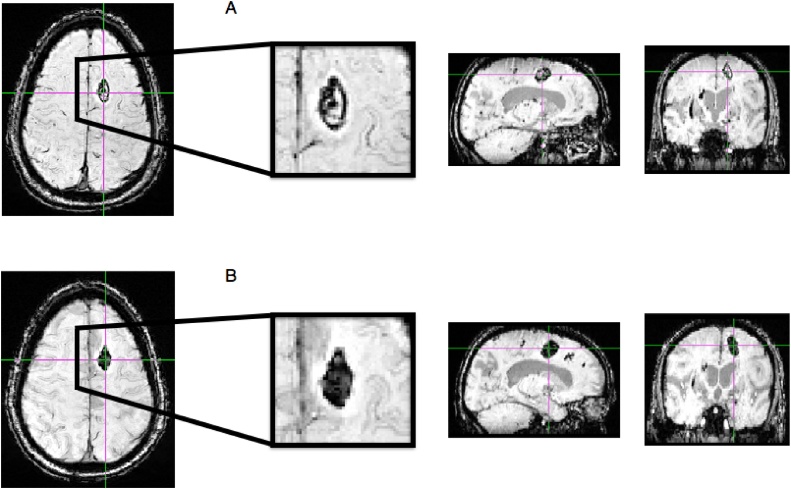
Susceptibility-weighted MR images illustrating change in volume in patient 2.Figure 3 Legend. Representative axial, coronal and sagittal images with magnified axial views of the left superior frontal gyrus region from patient 2 in whom an increase in total traumatic cerebral microbleed (TCMB) volume was seen between scan 1 (A) (1819 mm3) and scan 2 (B) (2845 mm3), 7 days apart. This patient did not experience an improvement in GCS between scans 1 and 2 and their overall clinical state worsened.